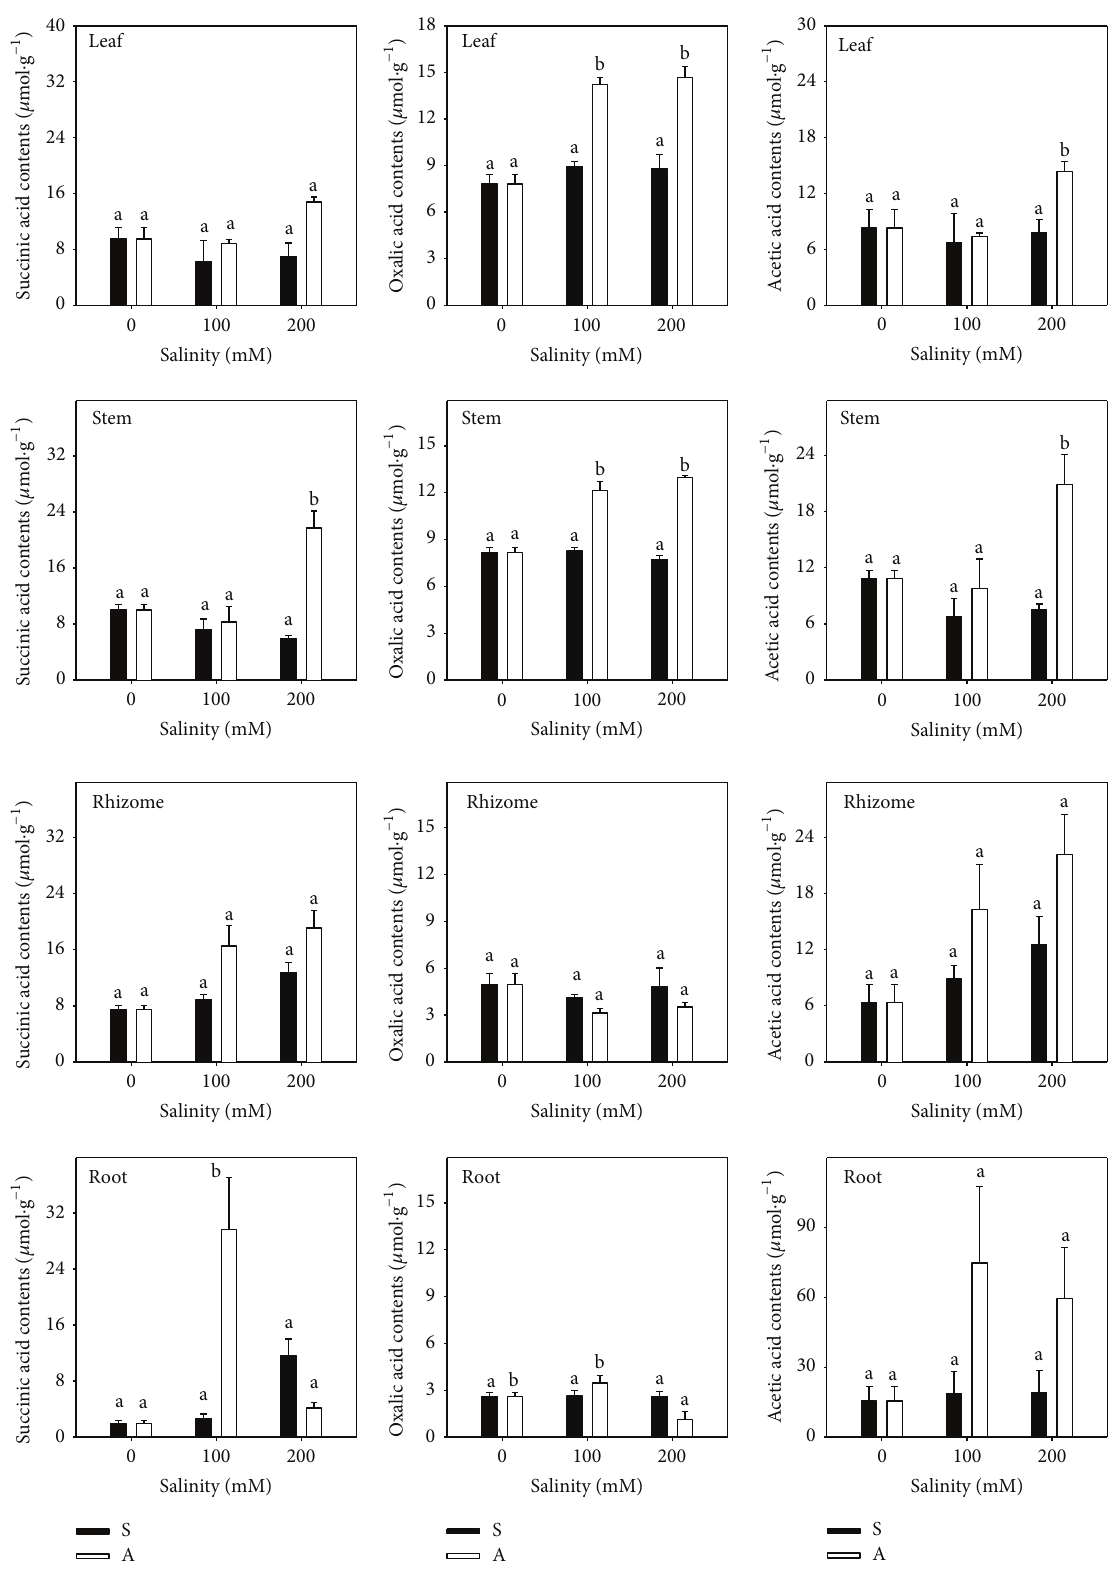
Figure 8: The micro organic acids components contents. The effect of salt stress (S) and alkali stress (A) on the succinic acid, acetic acid, and oxalic acid contents in rhizomes, stems, roots, and leaves of L. chinensis . There are three levels under both stresses: 0, 100, and 200 mmol/L. The means and standard errors are reported. Within each column, the different letters indicate significant difference among treatments ( 𝑃 < 0.05